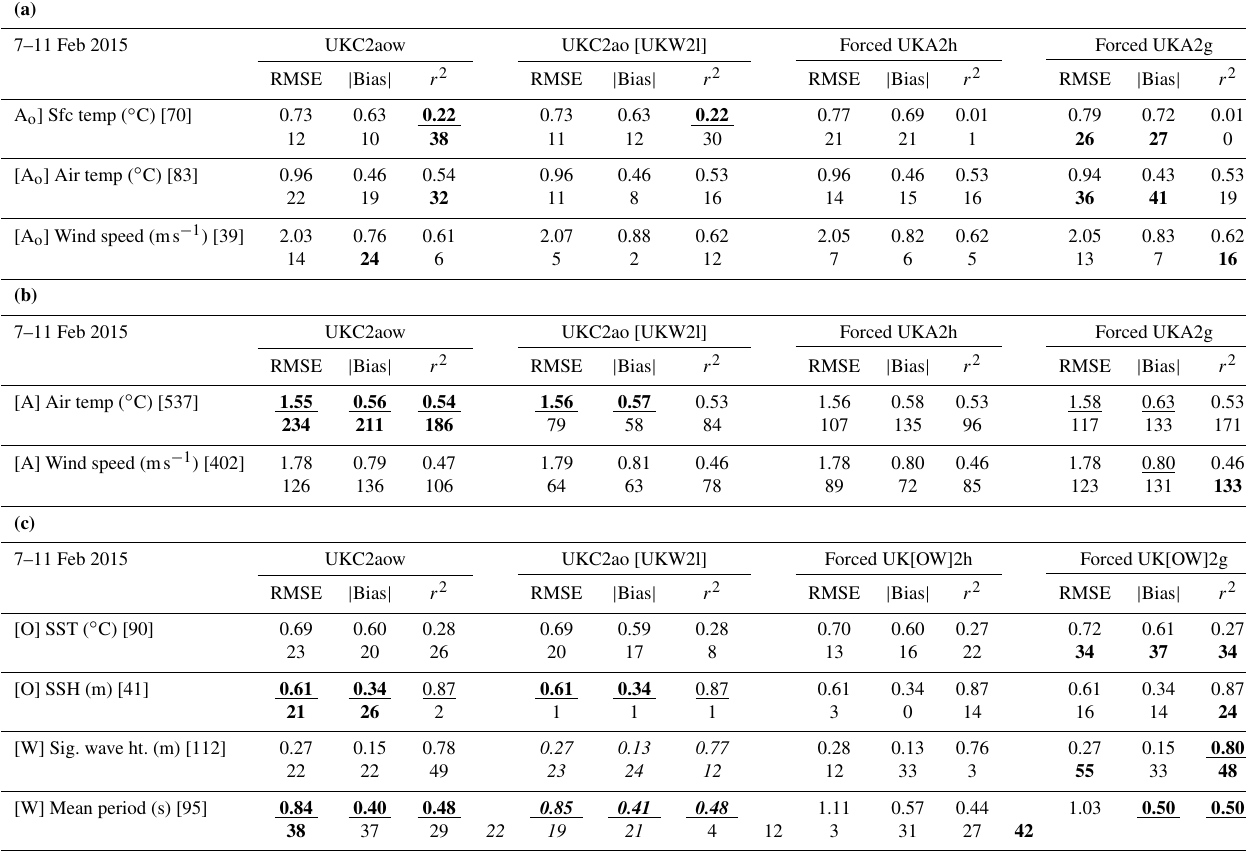
Table 8. Summary RMSE, bias and r 2 correlation coefficient statistics for the 7–11 February 2015 case study. Average statistics are computed from a comparison of model output against in situ observations of (a) atmosphere [A o ] model variables over sea grid cells only, (b) all atmosphere [A] model variables, and (c) ocean [O] and wave [W] model variables. The relevant forced configuration with high-resolution forcing UKW2h, UKO2h and UKA2h are treated as the reference control model. Results showing a statistically significant difference from the reference according to a t test at the 95% confidence level are underlined. Those also showing an improvement against the reference are also in bold. Also listed for each variable under the horizontal lines for each metric is the number of sites for which the model configuration provided the best statistic relative to the other model configurations tested for this case. The configuration with the highest number of sites listed is highlighted in bold. Numbers in square brackets show the number of observation locations assessed for each